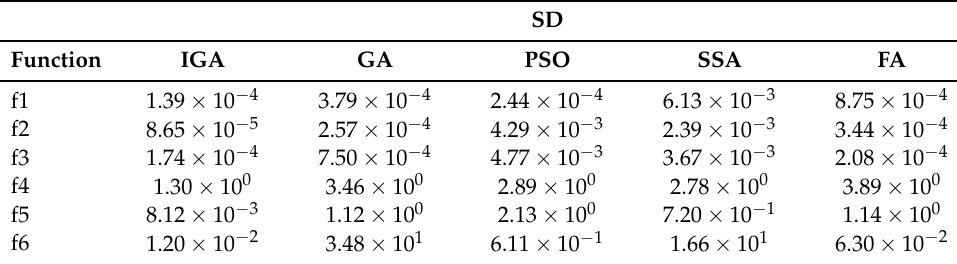
Table 5. SD different of test functions about six